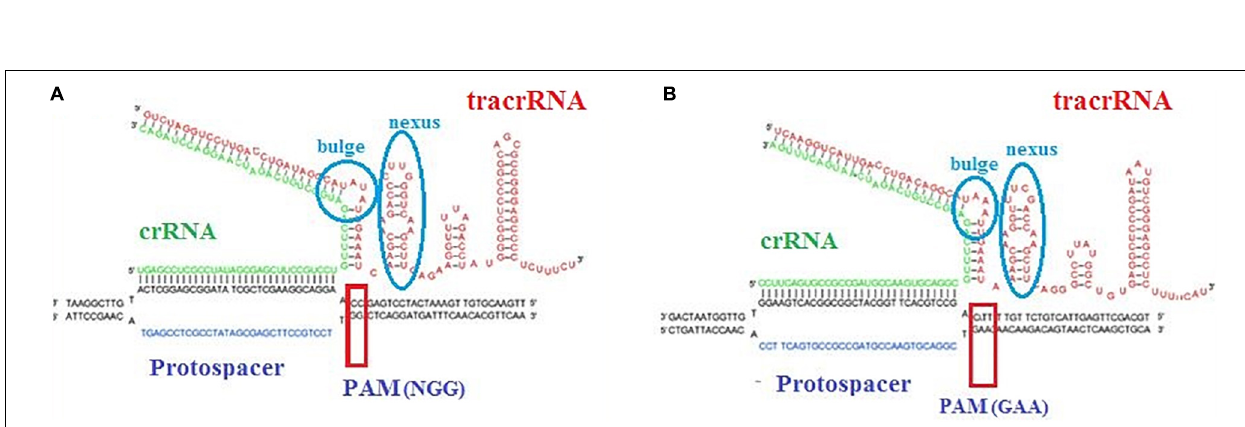
Frontiers in Microbiology |